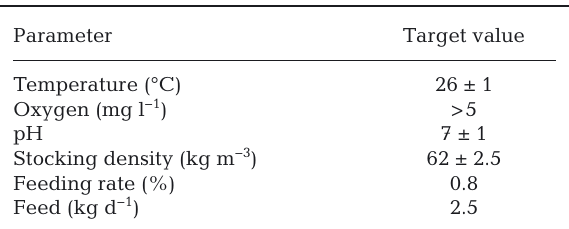
Table 1. Rearing conditions for tilapia during the experimental